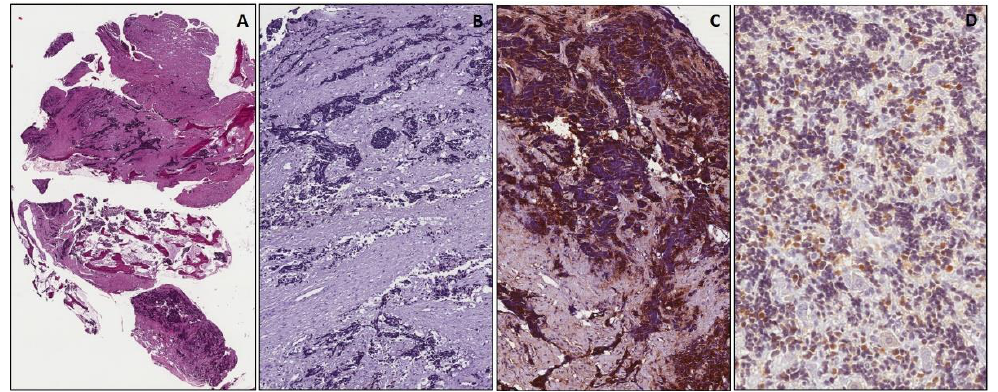
Figure 5. Ewing’s sarcoma confirmed by molecular analysis for EWSR1-FLI1 fusion. Small biopsy stained with hematoxylin & eosin ( A ); the diagnosis was confirmed by molecular analysis ( EWSR1- FLI1 fusion). In ( B , C ), two different areas of the same tumor showing, respectively, no immunostain- ing and positivity for CD99 not only restricted to neoplastic cells but also focally extending into tumor stroma (non-specific immunostaining due to sampling artefacts). Neoplastic cells showing diffuse nuclear staining for cyclin D1 ( D ). (( A ) original magnification 40 × ; ( B , C ): original magnification 100 × ; ( D ): original magnification 200 × ).